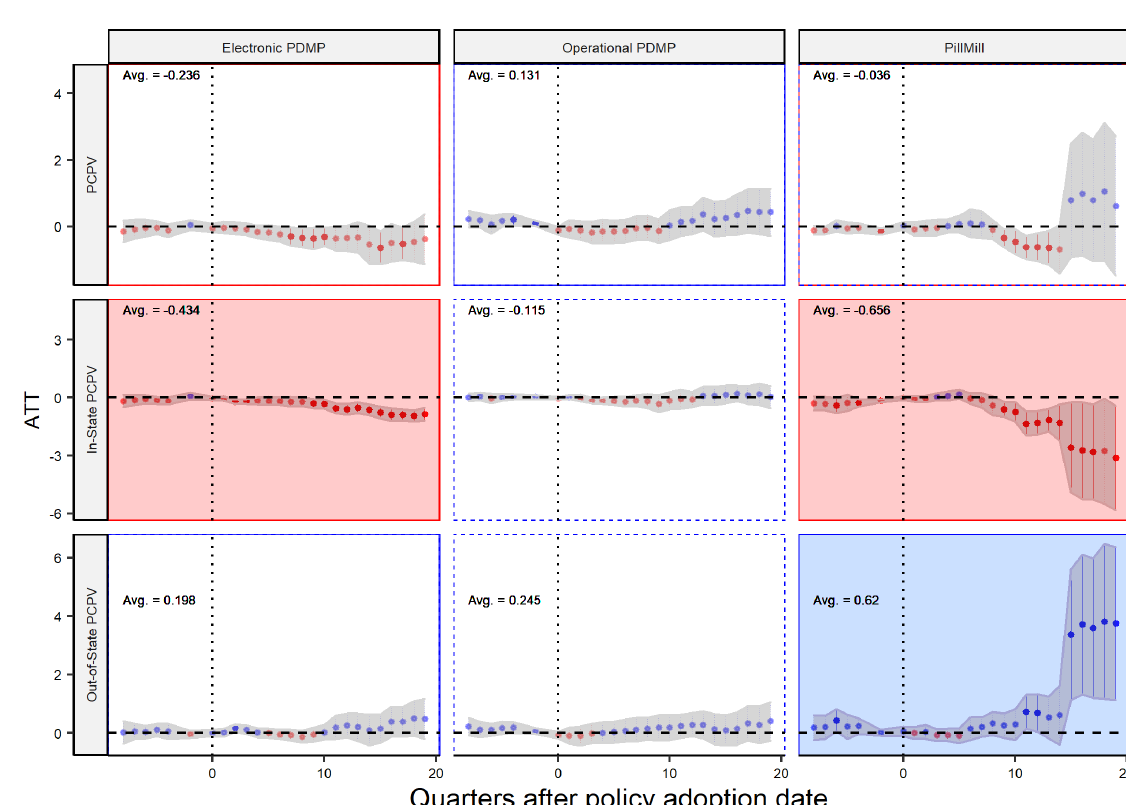
Figure 9. Policy Effect—Player: Retail Pharmacy.